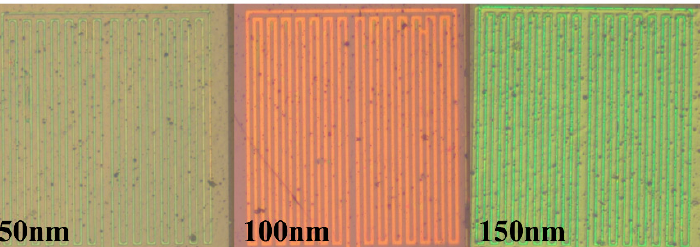
Figure 7. Optical micrograph of evaporated SnO 2 in different thicknesses (50, 100, 150 nm) (2.5 nm thick Pt is evaporated on the uppermost layer as catalyst layer).